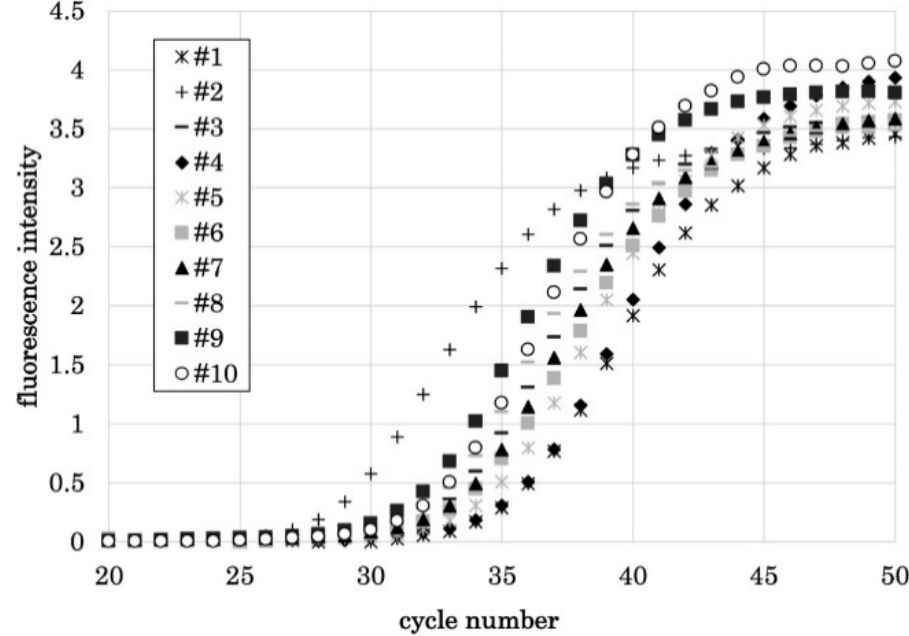
Figure 3. qPCR results of 10 subjects. Eight of the 10 subjects were able to perform qPCR for the first time without any problems. Two people were able to perform qPCR without any problem after a simple training. A stable result was obtained with an average Ct value of 27.56.